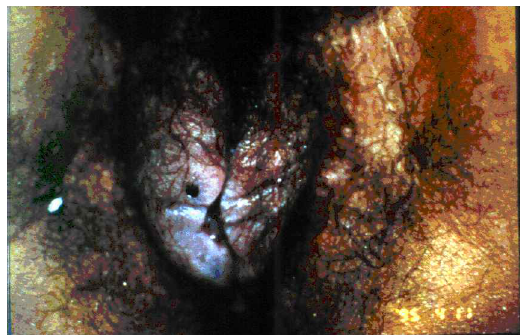
Figure 3 Case 1; the area shows complete wound cicatrization. Pregnancy was already